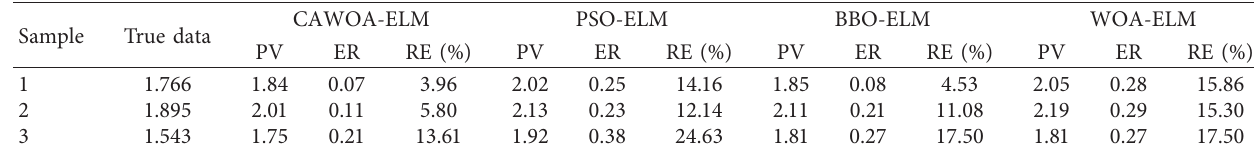
Table 2: Performance comparison of 4